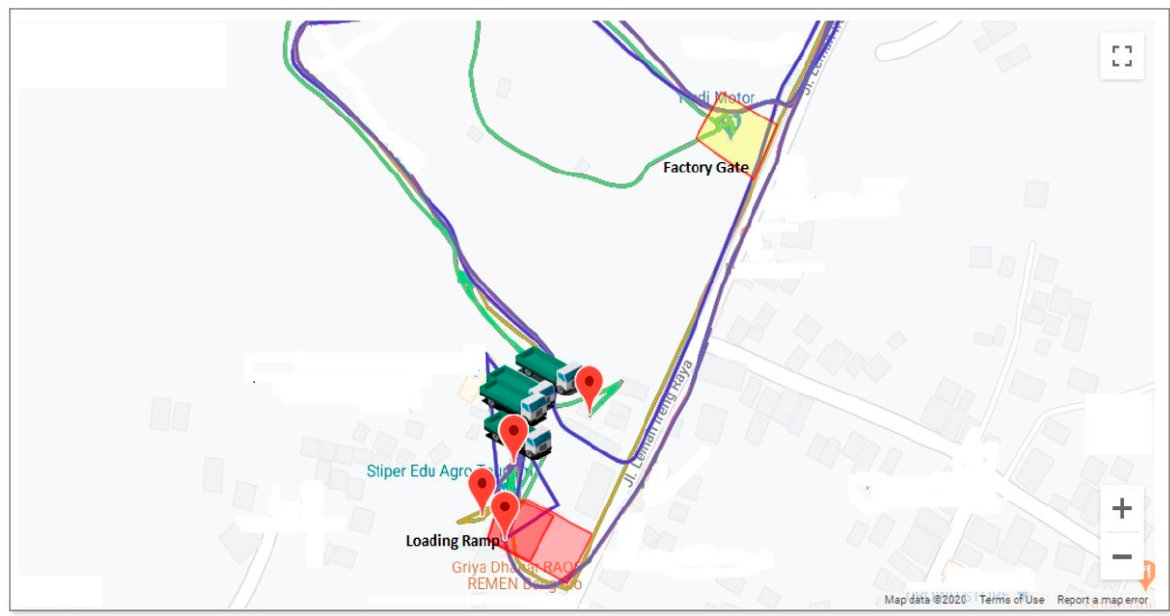
Figure 1. Examples of temporal-spatial types of data used in this research: the delivery path of the trucks is shown in colored line.